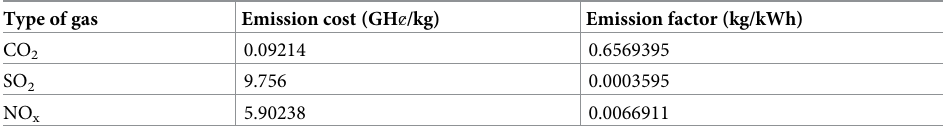
Table 1. Emission cost and emission factor of diesel generator [18,